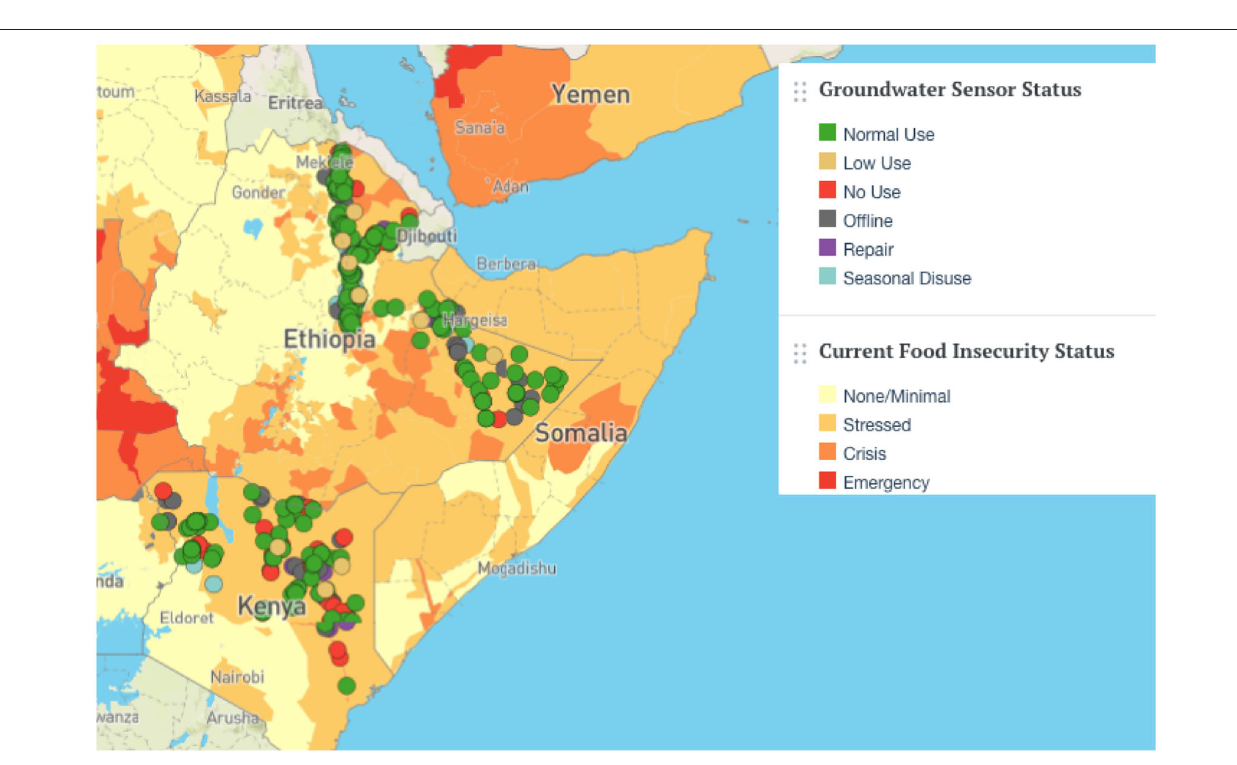
water supplies of ∼ 3 million people are being monitored on a daily